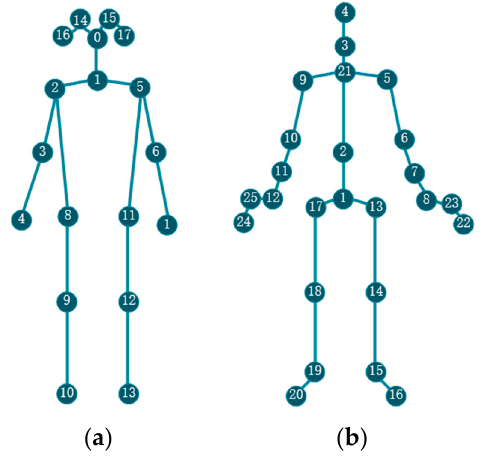
Figure 5. The skeleton structure in Kinetics and NTU RGB+D datasets. ( a ) The joint label and connection of Kinetics. ( b ) The joint label and connection of NTU RGB+D.